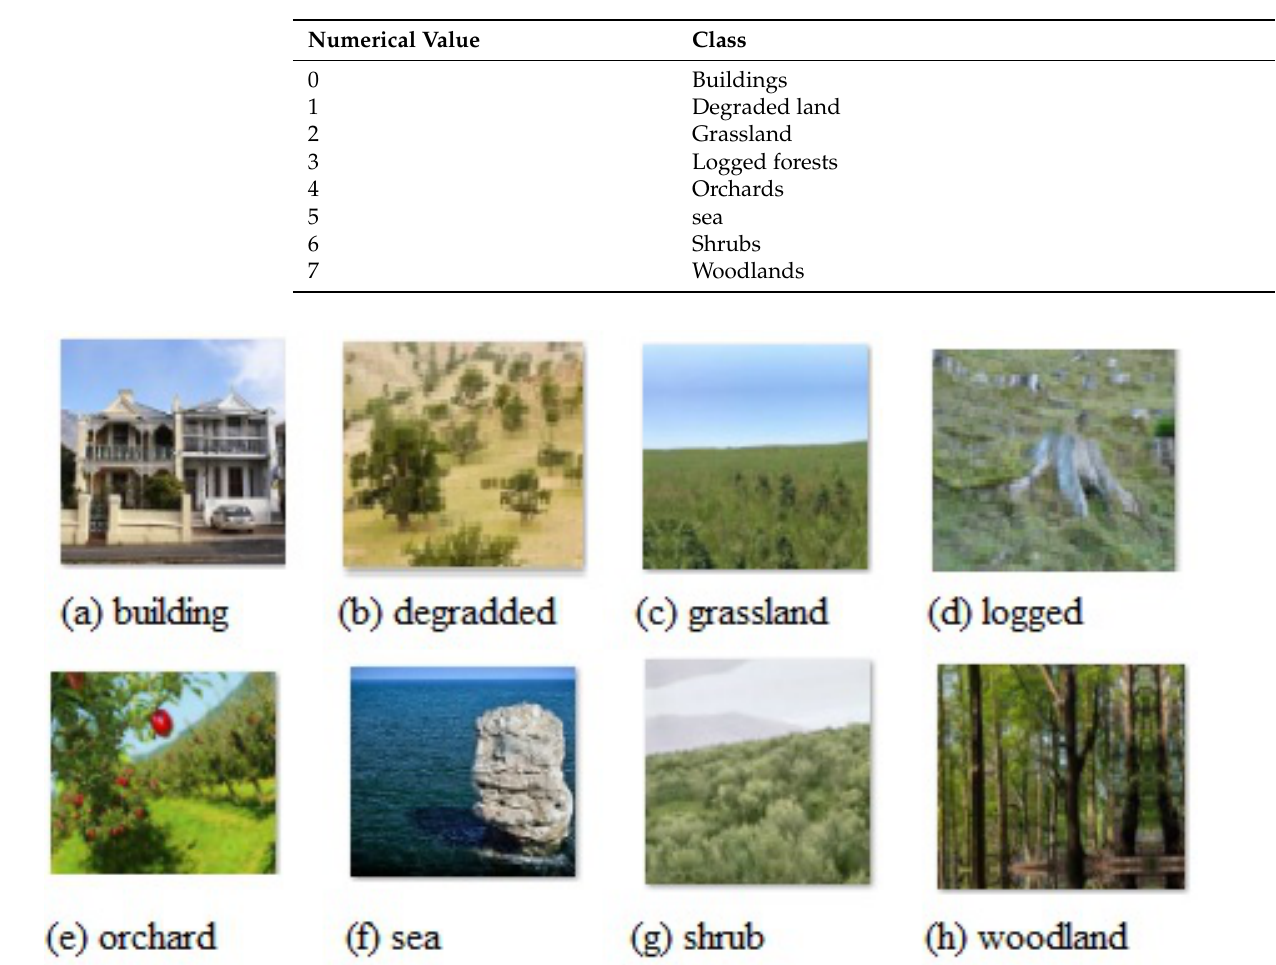
Figure 1. Sample of different types of forest images used in this